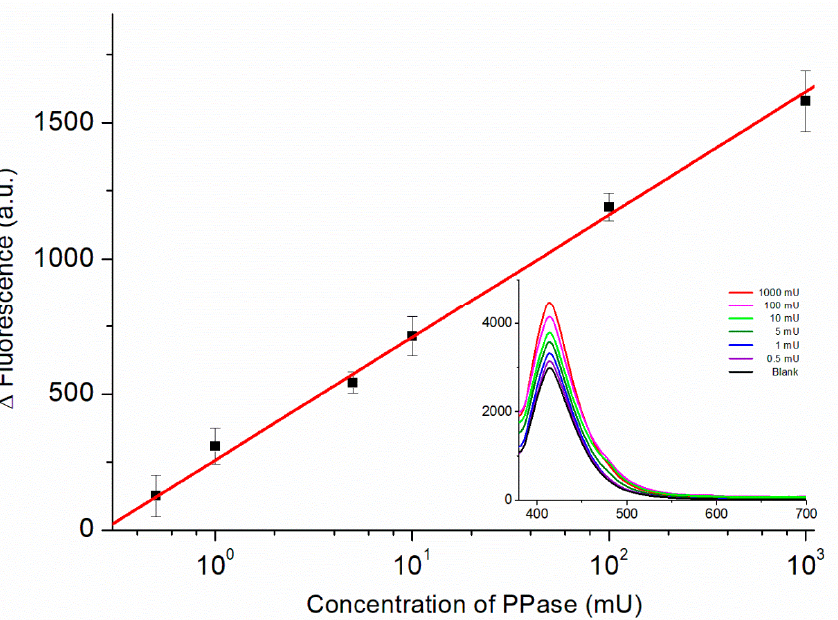
Figure 6. Calibration curve of the PPase biosensor for PPase concentrations from 0.5 to 1000 mU (logarithmic scale). Inset: Fluorescence spectra of the biosensor recorded in the presence of PPase at various concentrations used to obtain the calibration curve.